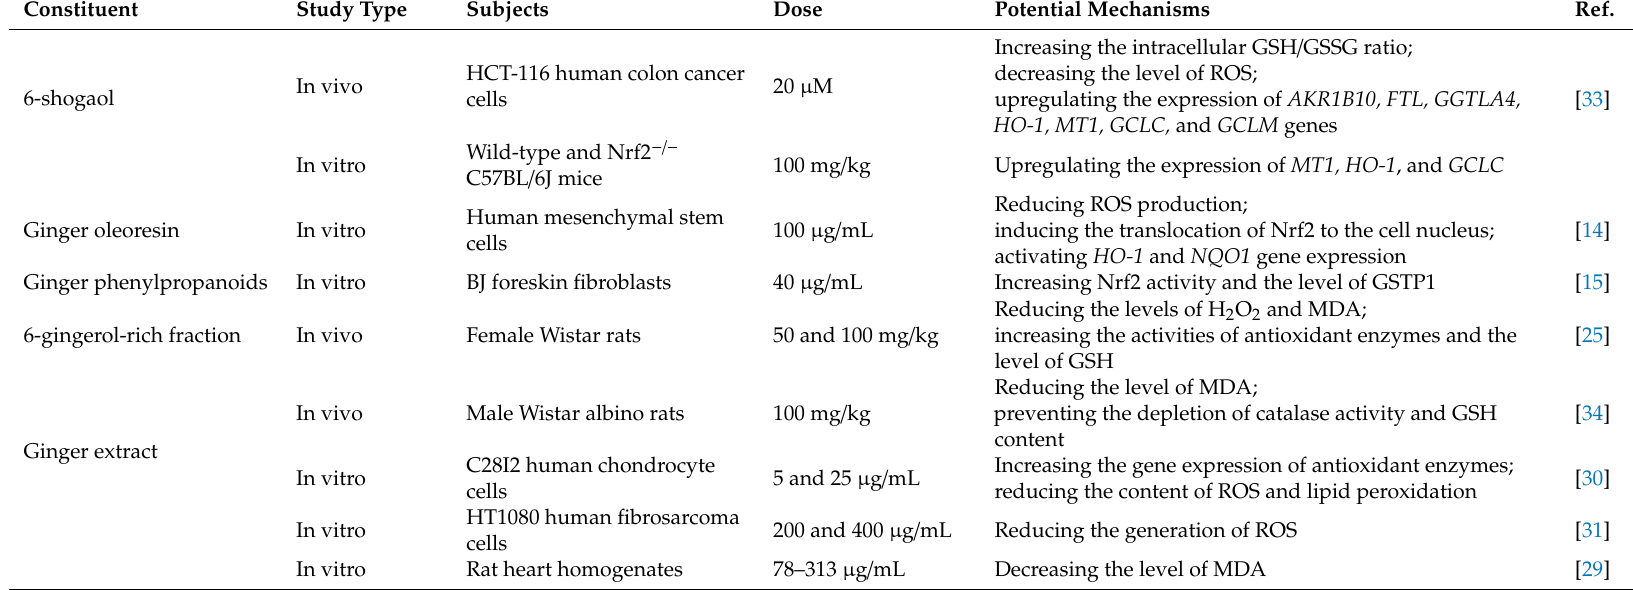
Table 1. The antioxidant activity and potential mechanisms of